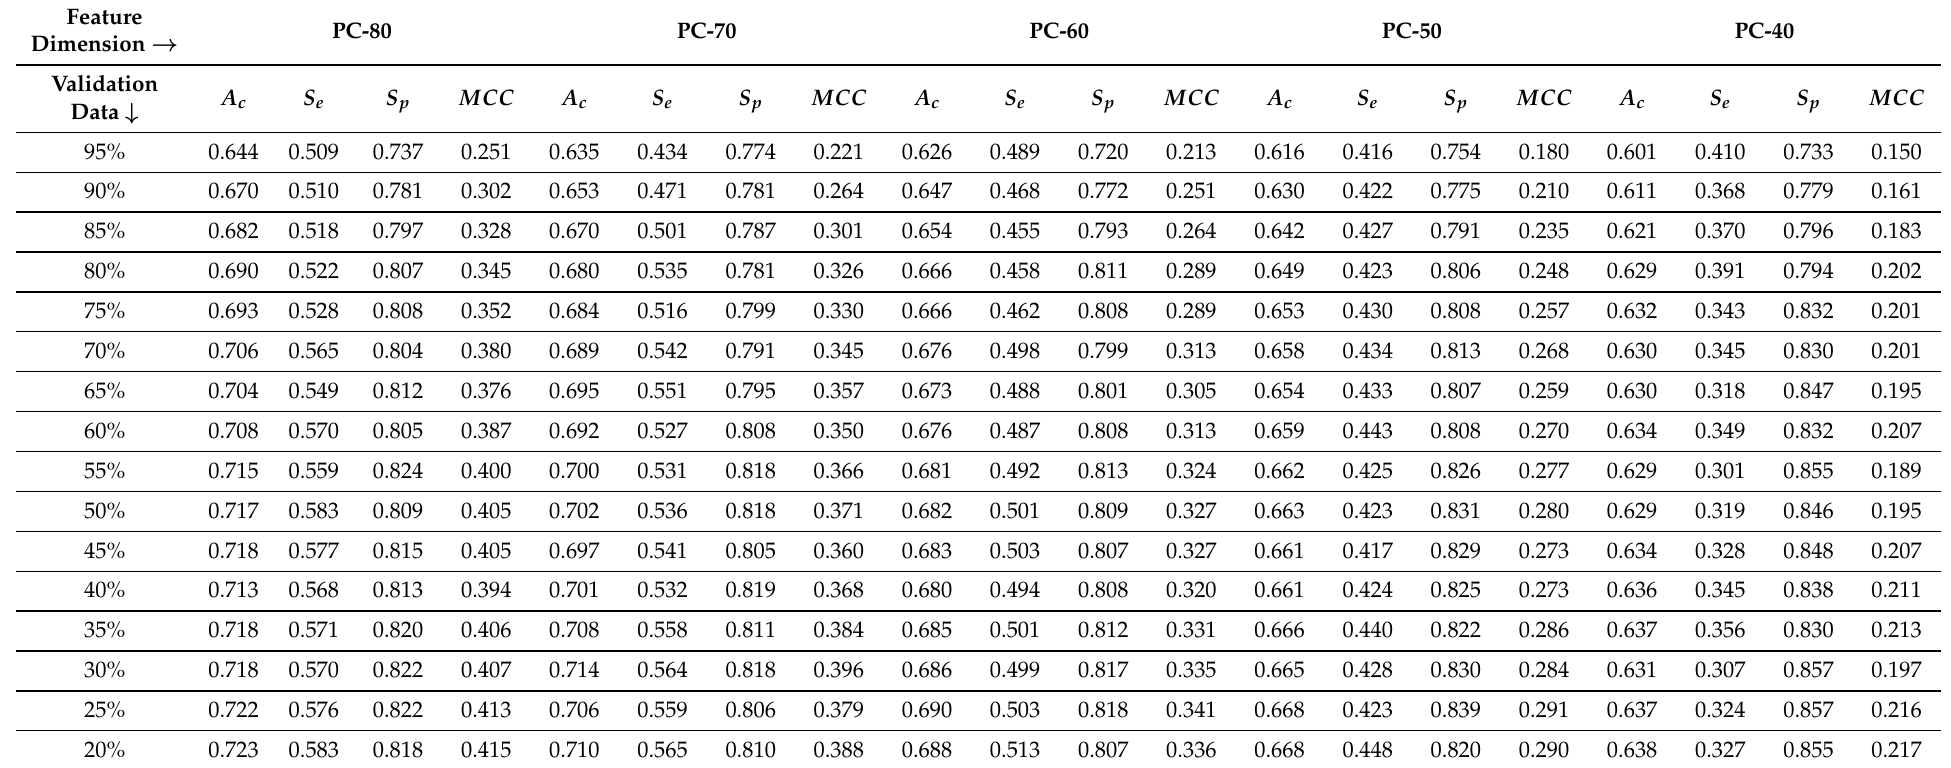
Table 5. The classification results over reduced feature space (i.e., extracted features from MammoWave’s original frequency response) after applying SVMs . (a) The classification results over reduced feature space (i.e., extracted features from MammoWave’s original frequency response) after applying SVM Q . (b)